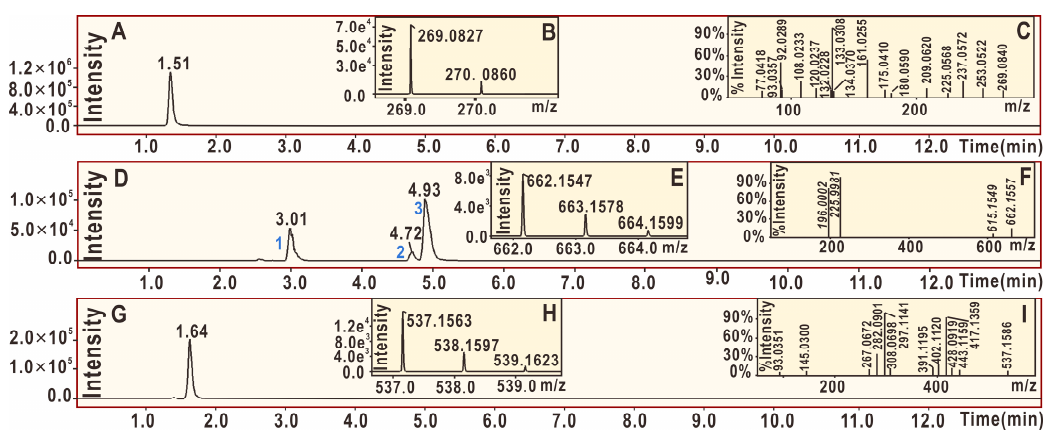
Figure 5. Resonance structures of the echinatin-4-O• radical ( A ) and the echinatin-4 ′ -O• radical ( B ).